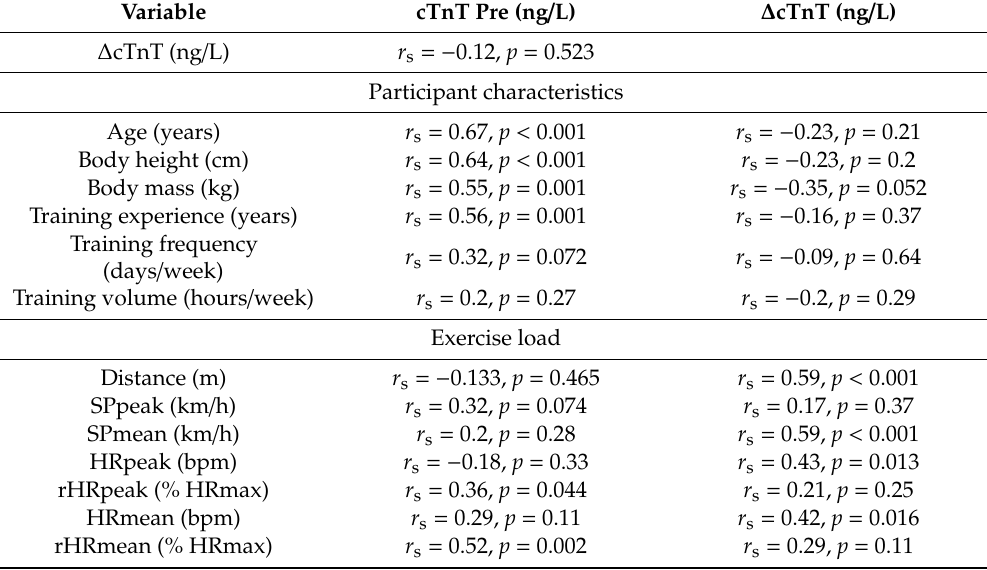
Table 3. Table of